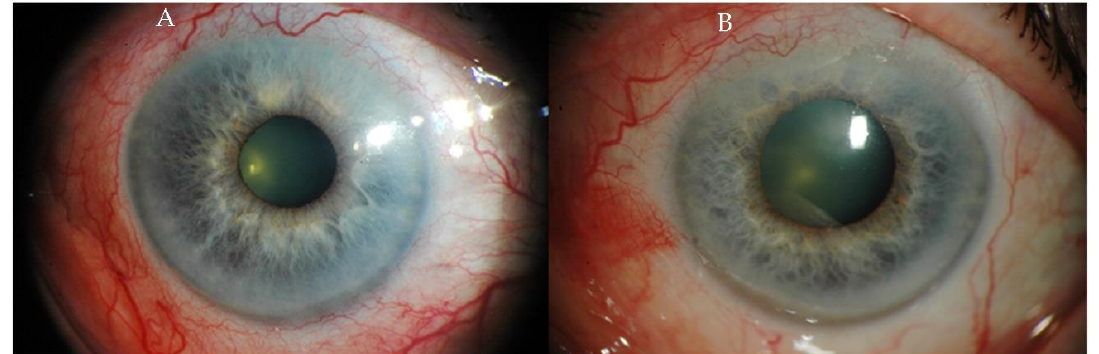
Figure 1. ( A , B ) Photographs of the anterior segment of the eye of a patient with sectoral episcleritis in the course of SLE. in the course of